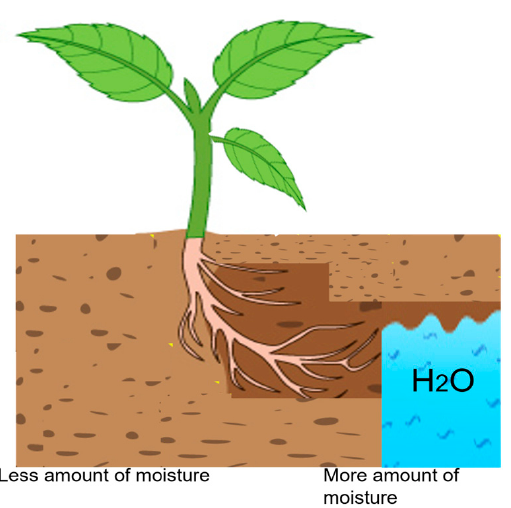
Figure 1. Movement of roots toward a high amount of water (hydrotropism). Figure 2 depicts the movement of roots toward water under dry and wet soil conditions. The graph also indicates that roots move more toward wet areas than to dry.